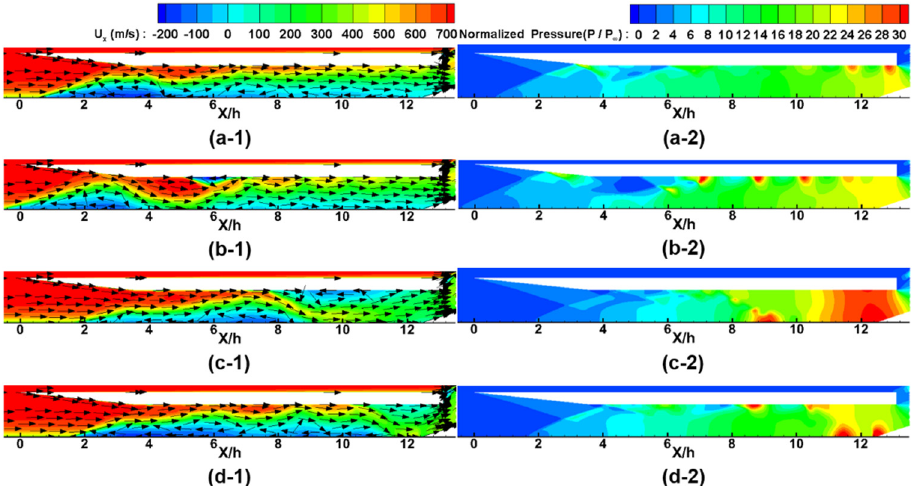
Figure 6. Axial velocity contours with velocity vectors ( left ) and normalized pressure contours ( right ) for Pattern 1: ( a-1 ) axial velocity at point [a]; ( a-2 ) normalized pressure at point [a]; ( b-1 ) axial velocity at point [b]; ( b-2 ) normalized pressure at point [b]; ( c-1 ) axial velocity at point [c]; ( c-2 ) normalized pressure at point [c]; ( d-1 ) axial velocity at point [d]; ( d-2 ) normalized pressure at point [d].